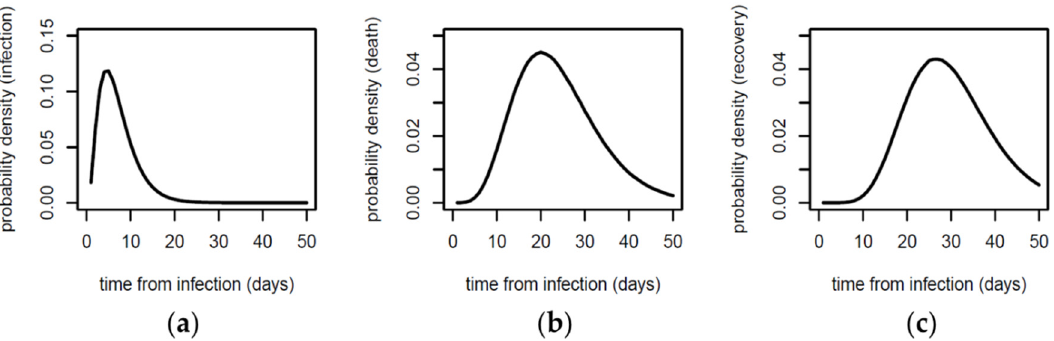
Figure 1. Probability distributions used in this work for ( a ) serial interval, ( b ) infection-to-death and ( c ) infection-to-recovery.